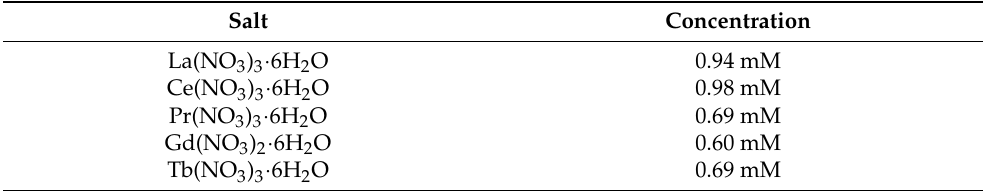
Table 1. List of millimolar concentrations of selected REE in REE[NO 3 ] 3 salt stock solution used for testing extraction performance of A336[NO 3